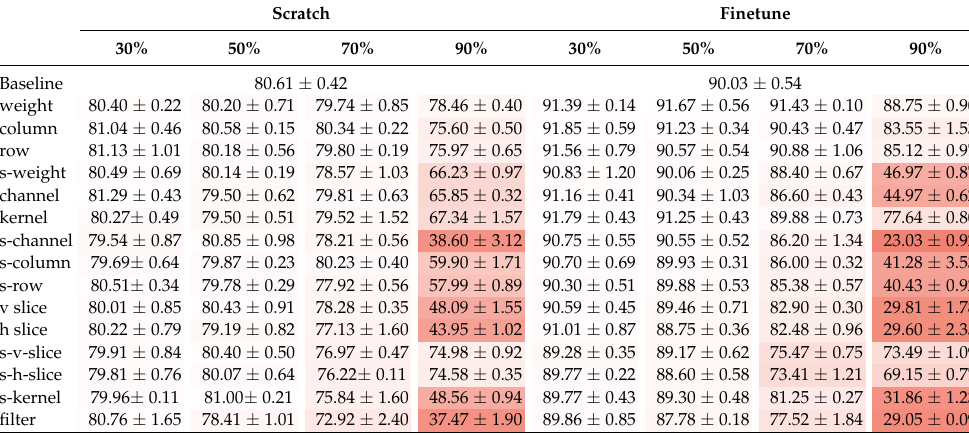
Figure 2. Common granularities, available in FasterAI. Weights are arranged in 9 filters of 3 channels and dimension 3 × 3, where colored weights are sparsified according to the chosen granularity. Table 1. Results of sparsifying ResNet-18 for all available granularities. Context, criteria and schedule are respectively set to local, large_final and one_cycle. Mean and standard deviation of accuracy over 3 rounds are reported. The darker the shade of red, the further the accuracy is from the